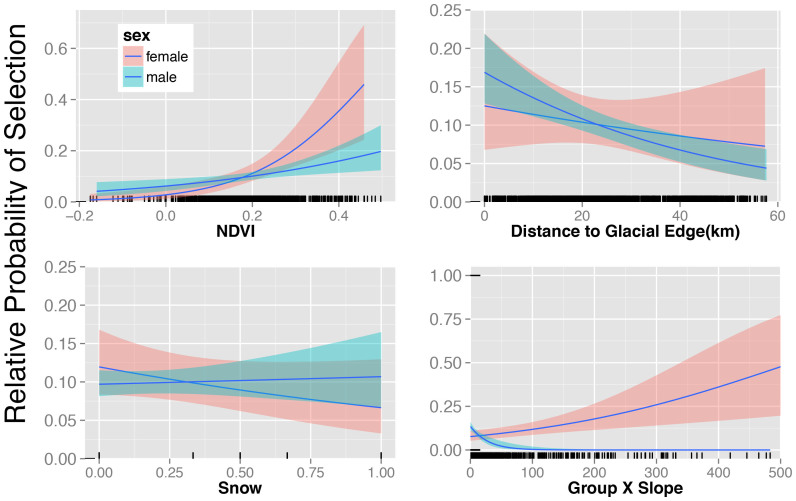
Resource selection by wild yaks for NDVI, snow cover, distance to nearest glacier and the interaction between slope and group size in the Tibetan Plateau during surveys in 2006 and 2012, showing, where supported, group-size (sex) dependent differences in resource selection.